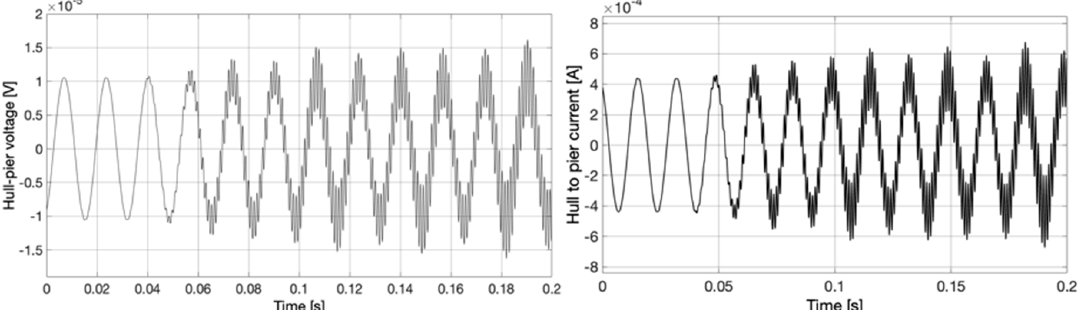
Figure 11. Simulink model #1 numerical experiments results for asymmetrical shore cables capacitances (0.030, 0.028, 0.033 μ F), asymmetrical vessel cables capacitances (0.0030, 0.0028, 0.0033 μ F), asymmetrical supply voltages (±3 V) and stray current path resistance equaling 0.024 ohms. Hull—pier AC voltage ( left ), stray alternating current waveform ( right ).